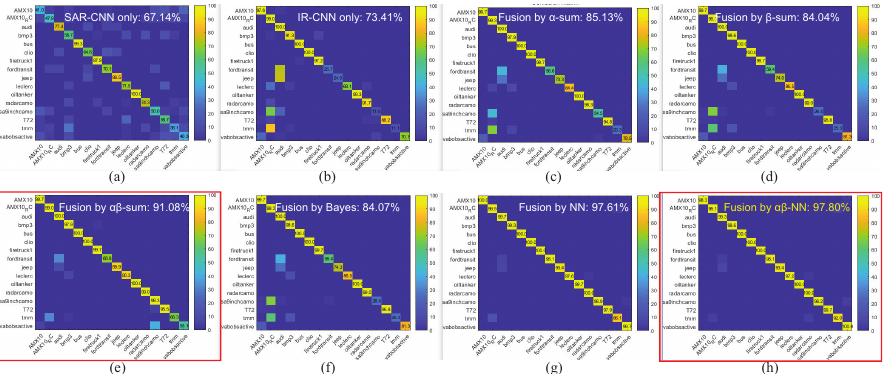
Figure 21. Confusion matrices at the rotation angle k = 3.5 ◦ : ( a ) SC; ( b ) IC; ( c ) α -sum; ( d ) β -sum; ( e ) αβ -sum (proposed linear fusion scheme I); ( f ) BF [57]; ( g ) NN; and ( h ) αβ -NN (proposed nonlinear fusion scheme II).